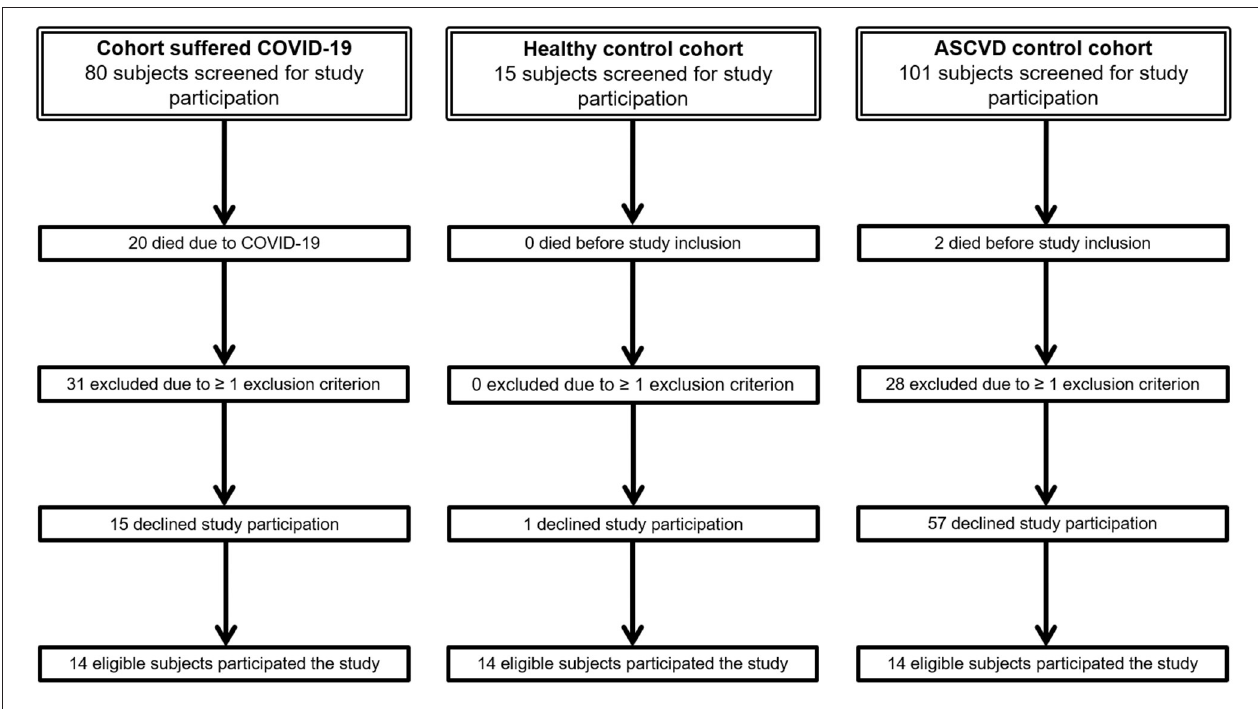
FIGURE 1 | Flow chart of study